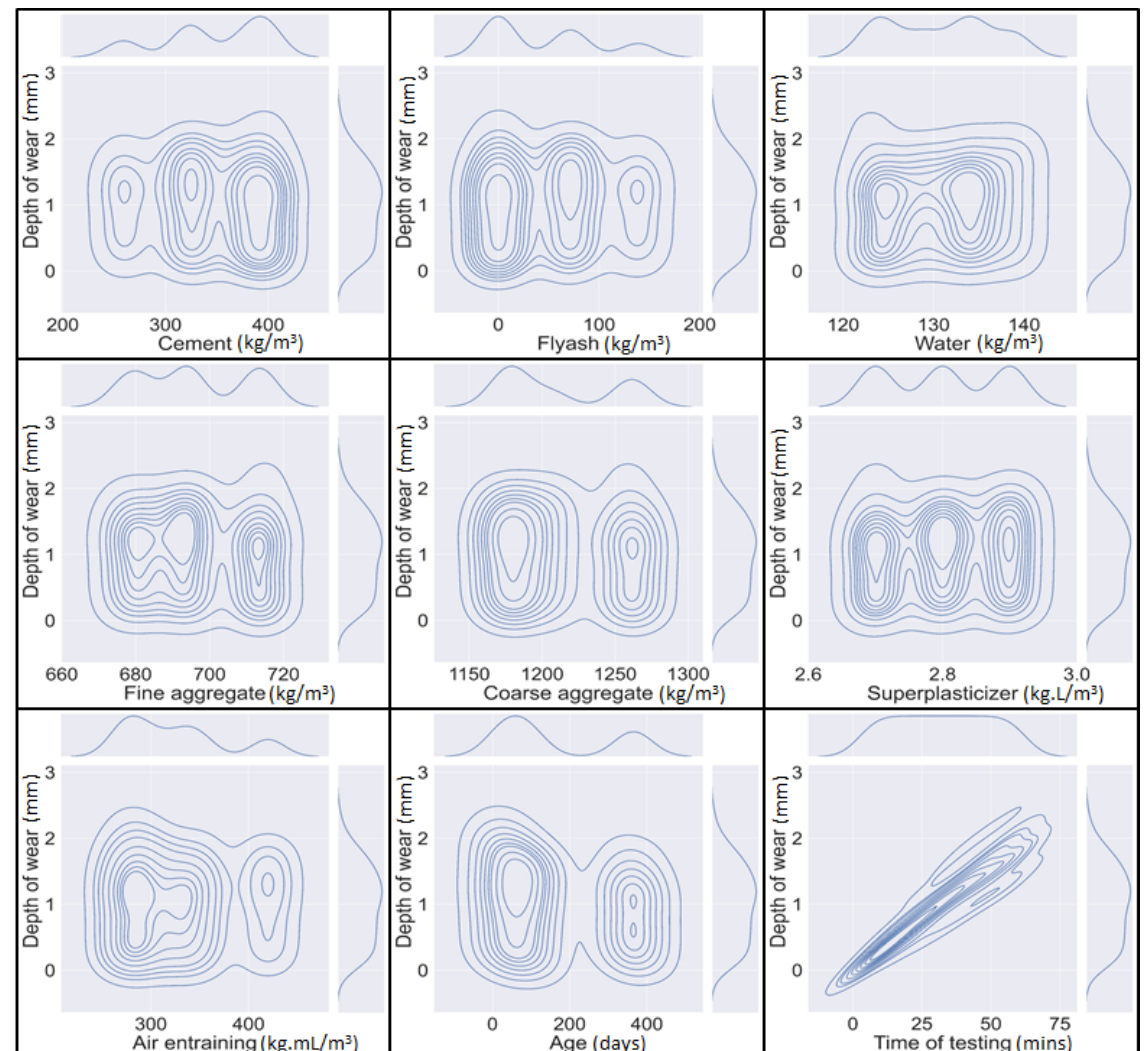
Figure 2. Python-based contour plot between explanatory and response parameter.